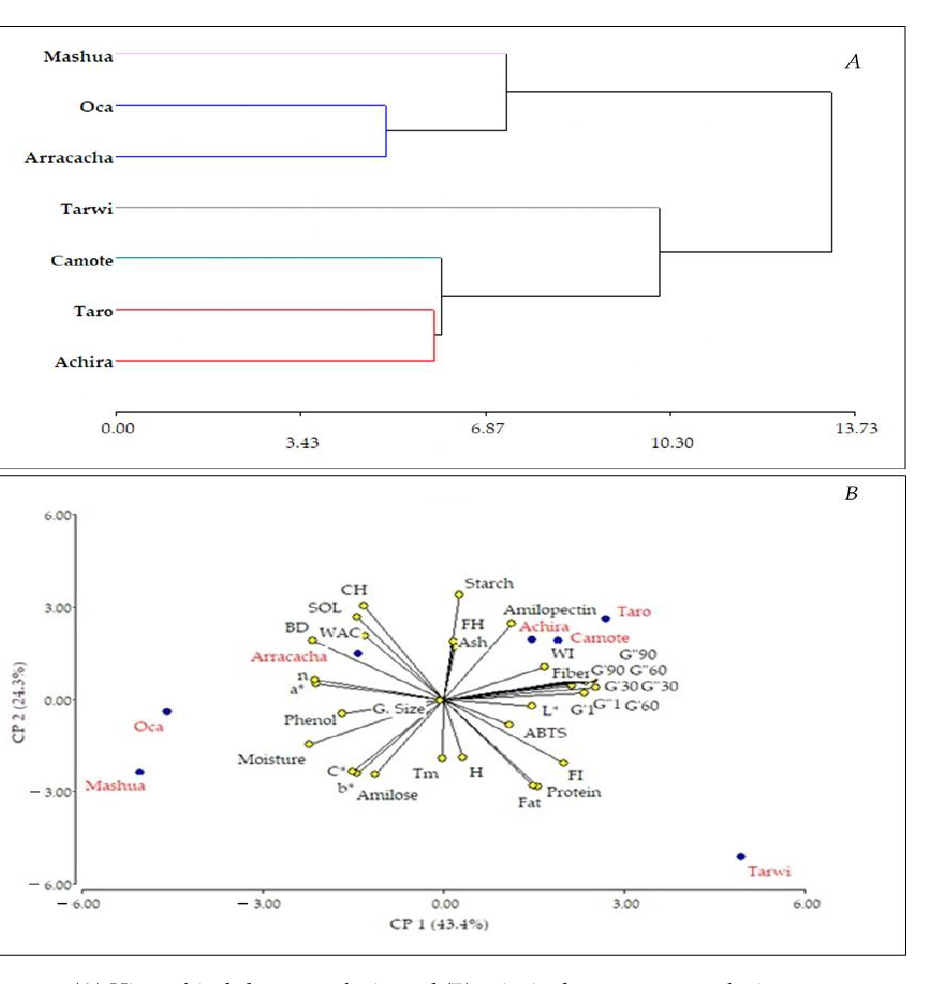
Figure 7. ( A ) Hierarchical cluster analysis, and ( B ) principal component